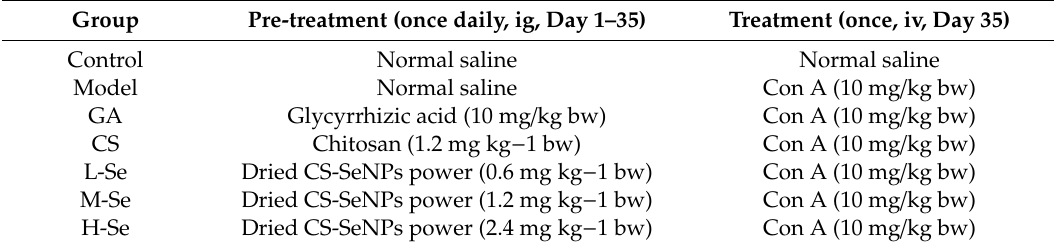
Table 1. Administration of the treatments during the concanavalin A (Con A) challenge experiment (Kunming (KM) mice, n =